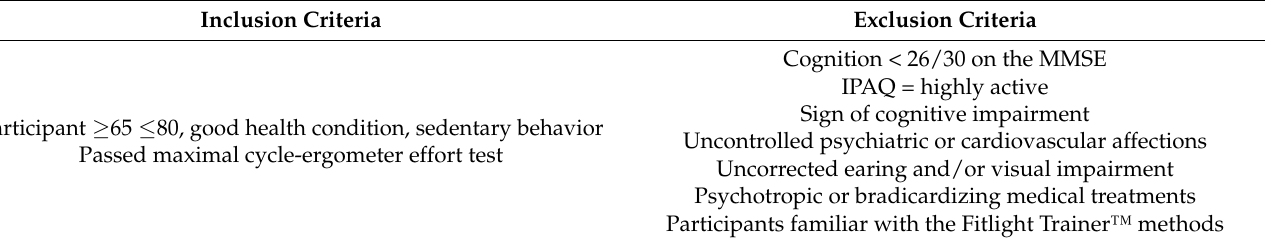
Table 1. Inclusion and exclusion